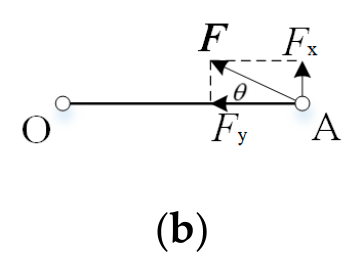
Figure 11. Schematic diagram of radial member force. ( a ) Unbalanced force diagram; ( b ) decomposi- tion of